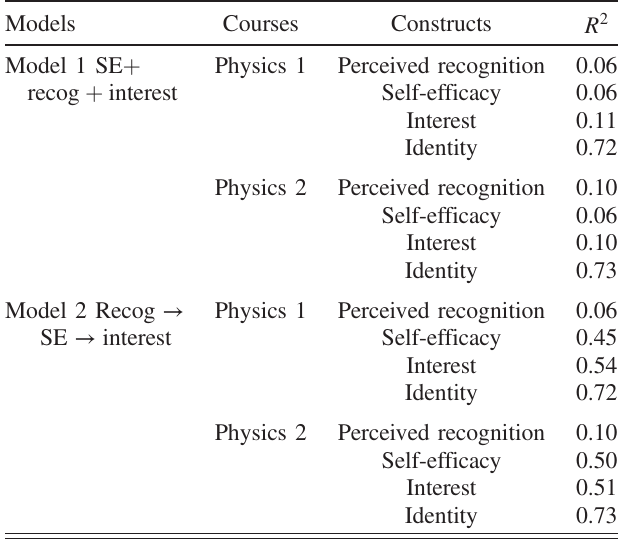
TABLE VIII. Coefficient of determination ( R 2 ) for various constructs in different models. All R 2 values are significant and p values < 0 . 001 . In model 1, there are only covariances between each pair of constructs: physics self-efficacy, perceived recog- nition, and interest. In model 2, the arrows indicate the direction of the predictive